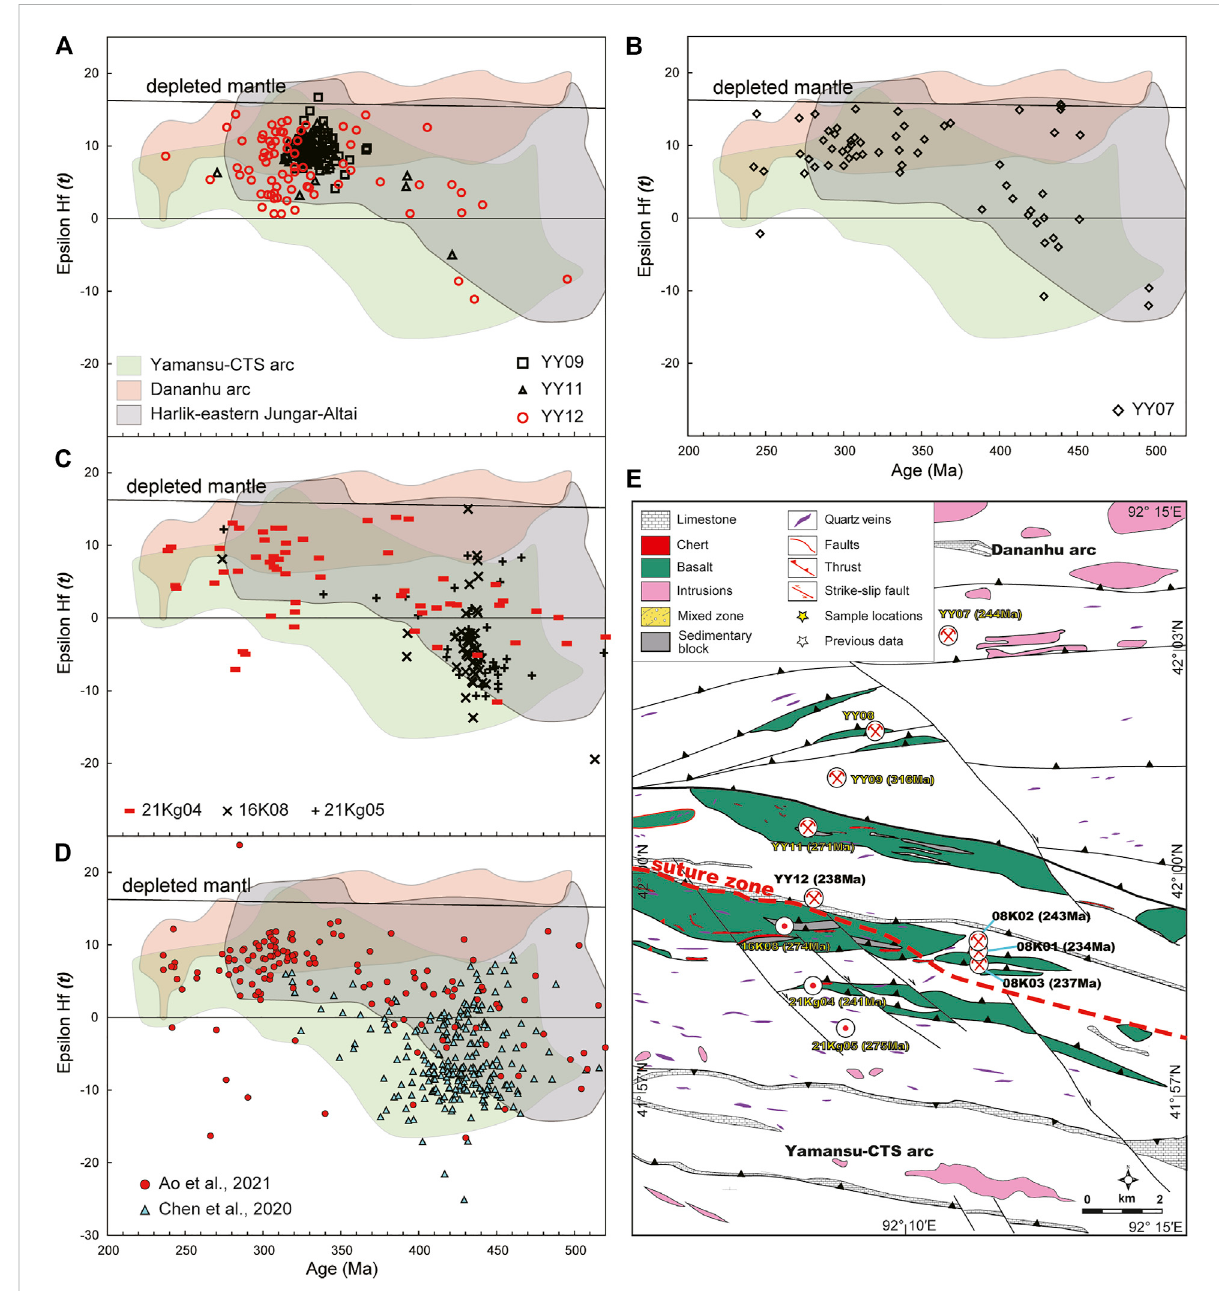
FIGURE 13 Hfisotope diagram of dated sandstones from the KGSC. (A) Shows that the sandstone matrix (Samples YY09 and 11) was probably derived from theDananhuintraoceanicarctothenorth. (B) Showsthatthesandstonematrix(SamplesYY07and12)wasprobablyderivedfromthesouthernSouth Mongolian-Dananhu Andean arc to the north in the Triassic. (C) Shows that the sandstone matrix (Samples 16K08, 21Kg04 and 05) was probably derivedfromtheYamansu-CTSarc. (D) TheHfisotopesofthesandstonematrixsamplesfromtheKGSCintheYamansu area(Chenetal.,2019) and the HL area (Ao et al., 2021). (E) Suture line between Samples YY12 and 16K08 in the N – S-trending cross-section in the HL area. The Hf isotopic data are provided in Supplementary Table